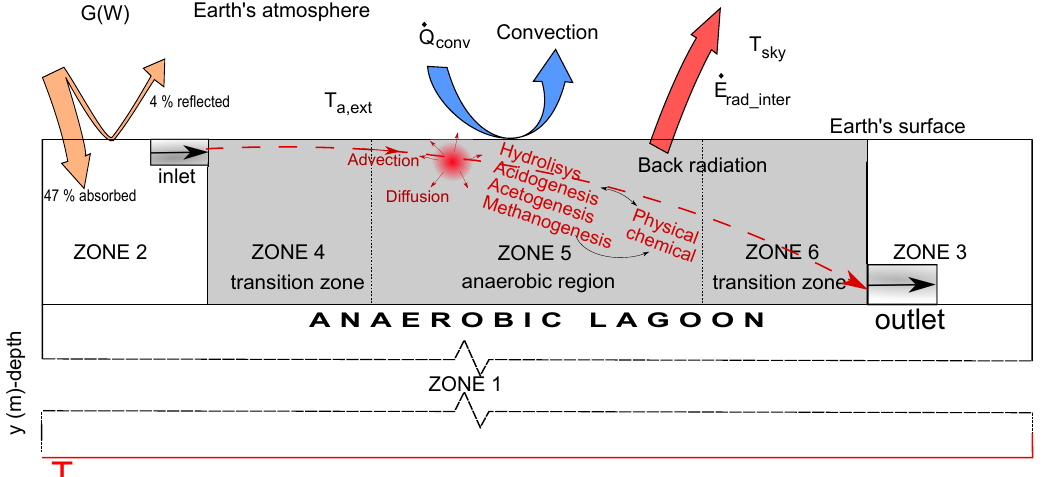
Figure 1. Scheme of the different phenomena that take places in AL and their environments.